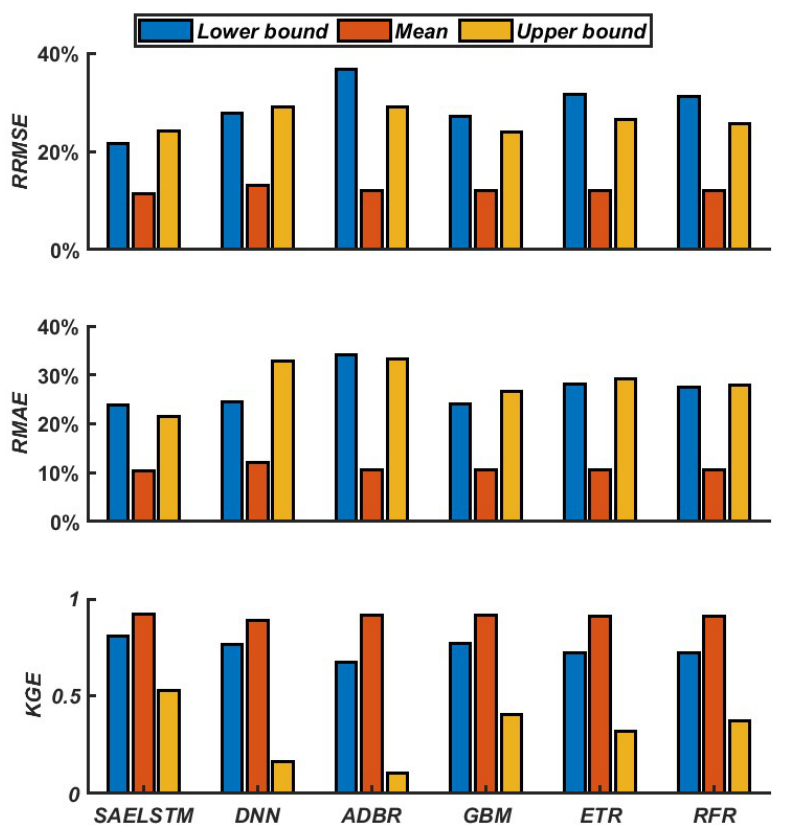
Figure 13. Performance metrics comparison of the proposed SAELSTM and other comparative counterpart models for upper, lower, and mean predication in terms of RRMSE , RMAE , and KGE .